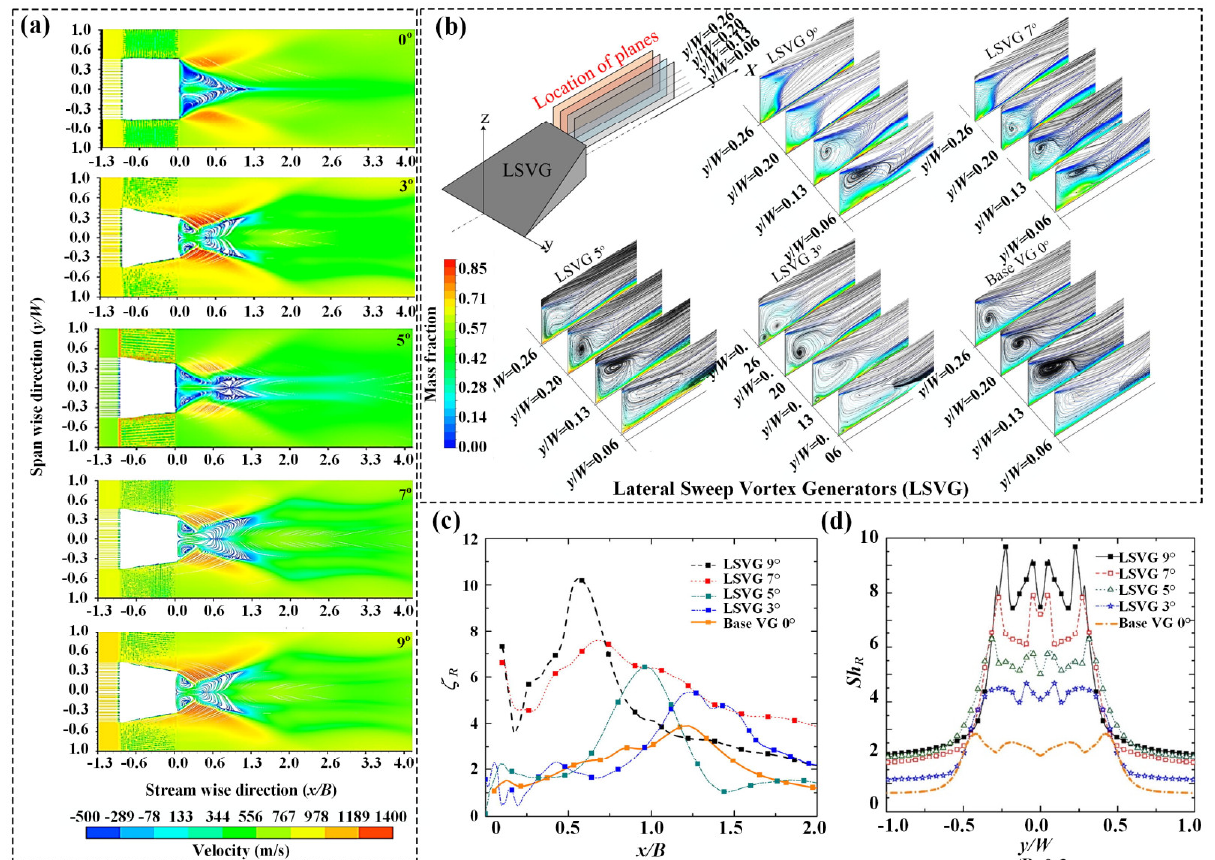
Figure 6. Ekman layer evolution characters of free sink vortex. ( a ) Laminar flow phenomenon. ( b ) Lundgren’s equations with surface tension and without surface tension. Reproduced with the per- mission of the Cambridge University Press. (Reprinted with permission from Ref. [68]. 2006, Cam- bridge University Press.) ( c ) Generation and progression of the air core. ( d ) Progression of the vor- ticity distribution. Reproduced with the permission of Elsevier. (Reprinted with permission from Ref. [71]. 2011, Elsevier.)